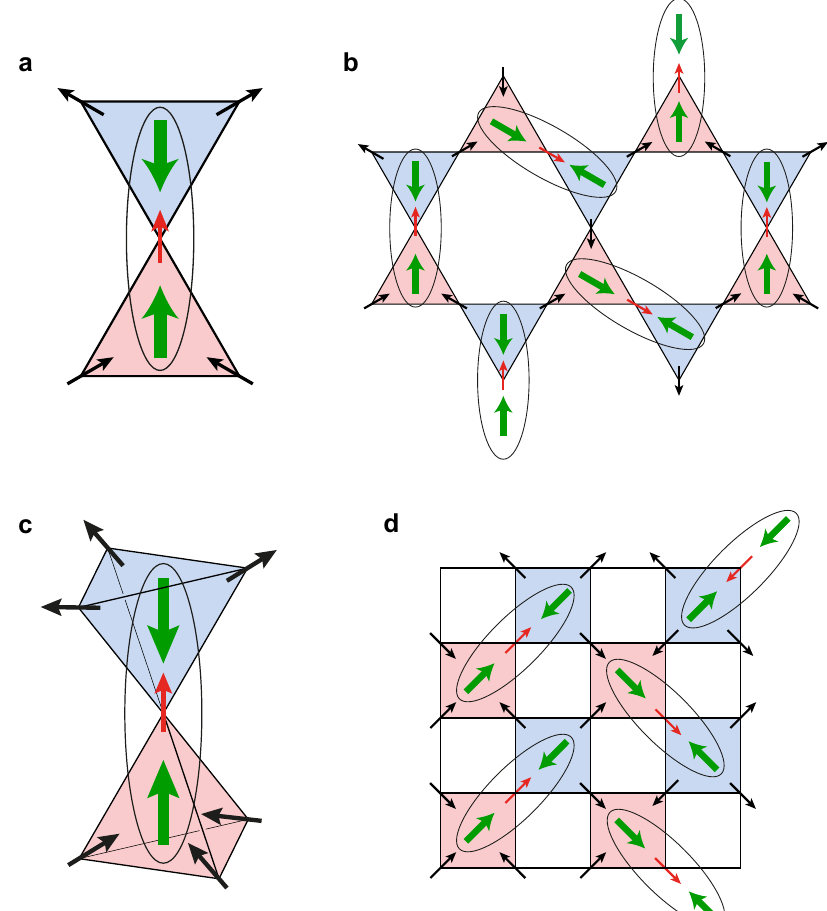
Fig. 2 Moment fragmentation state and electric dipoles in this state in kagome and pyrochlore spin ice. a Monopole--antimonopole pair (the main building blocks of kagome system with moment fragmentation) with common ‘ special ’ spin (red arrow), demonstrating the pairing of opposite dipoles (formation of ( d , − d ) pairs). b Example of a moment fragmentation state in kagome spin ice with ordered monopoles, disordered spins and paired dipoles. c Pair of tetrahedra with monopole--antimonopole with a common ‘ special ’ spin, demonstrating the formation of paired ( d , − d ) dipoles. d An example of moment fragmentation state in a pyrochlore system with ordered monopoles, disordered spins and paired dipoles. The ( d , − d ) pairs are marked by ovals. Colour coding is the same as in Fig.